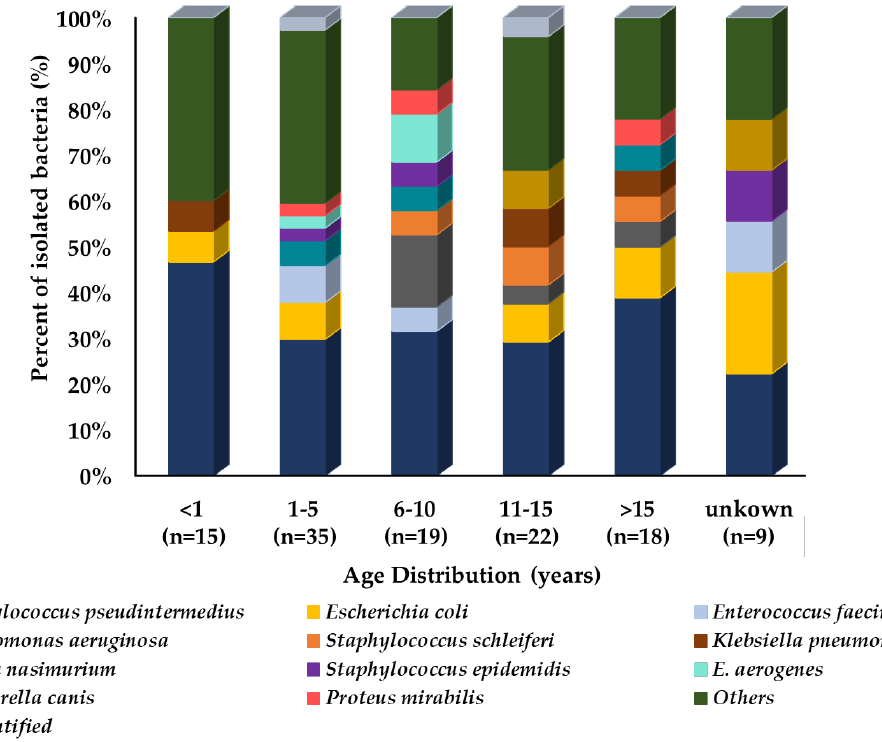
Figure 5. Prevalence of isolated bacteria (%) from dogs ’ respiratory specimens by age group (n = 118). In the graph, “ n ” represents the number of recovered